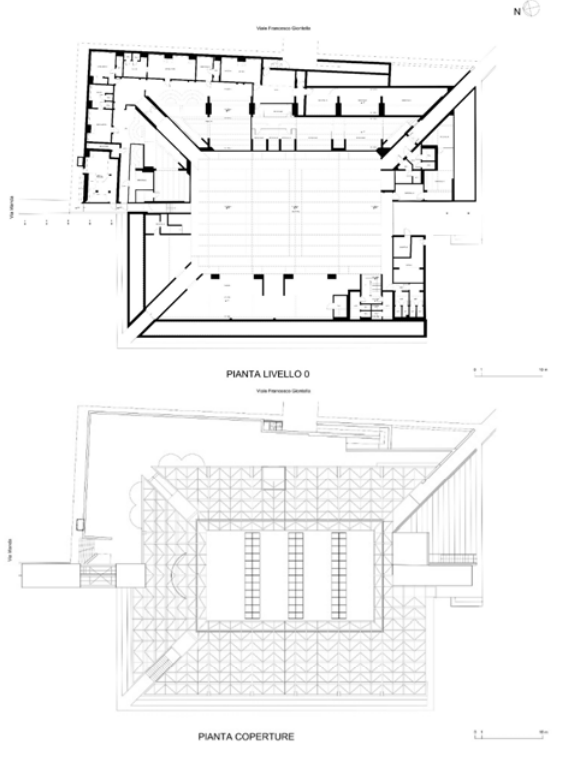
Figure 7 . The plans of the surveyed building.